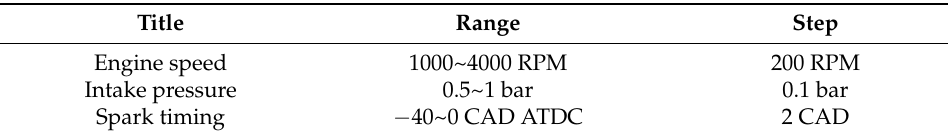
Table 3. Simulation setup.